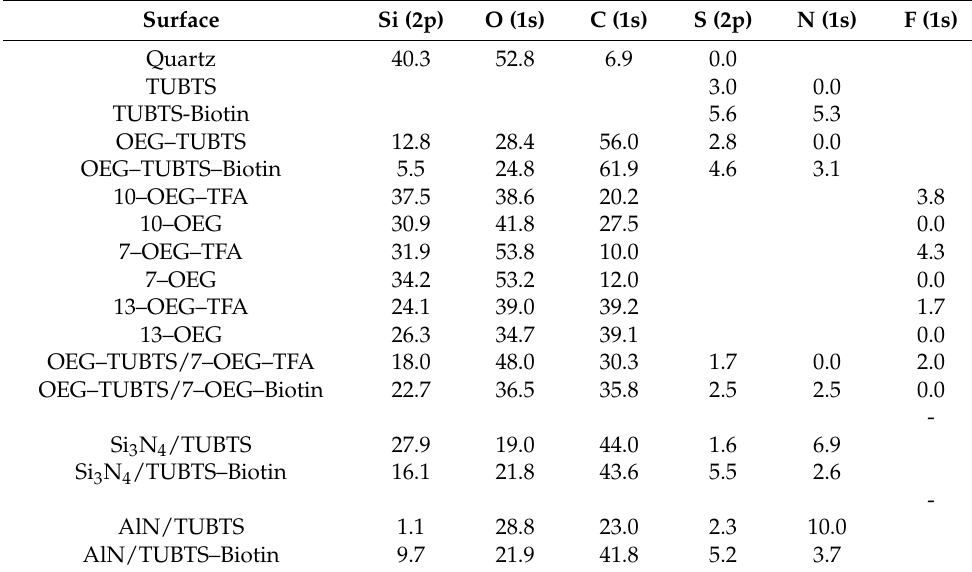
Table 2. Relative atomic percentages for elements present on material surface from XPS signals obtained at 20 ◦ angle relative to the surface 1